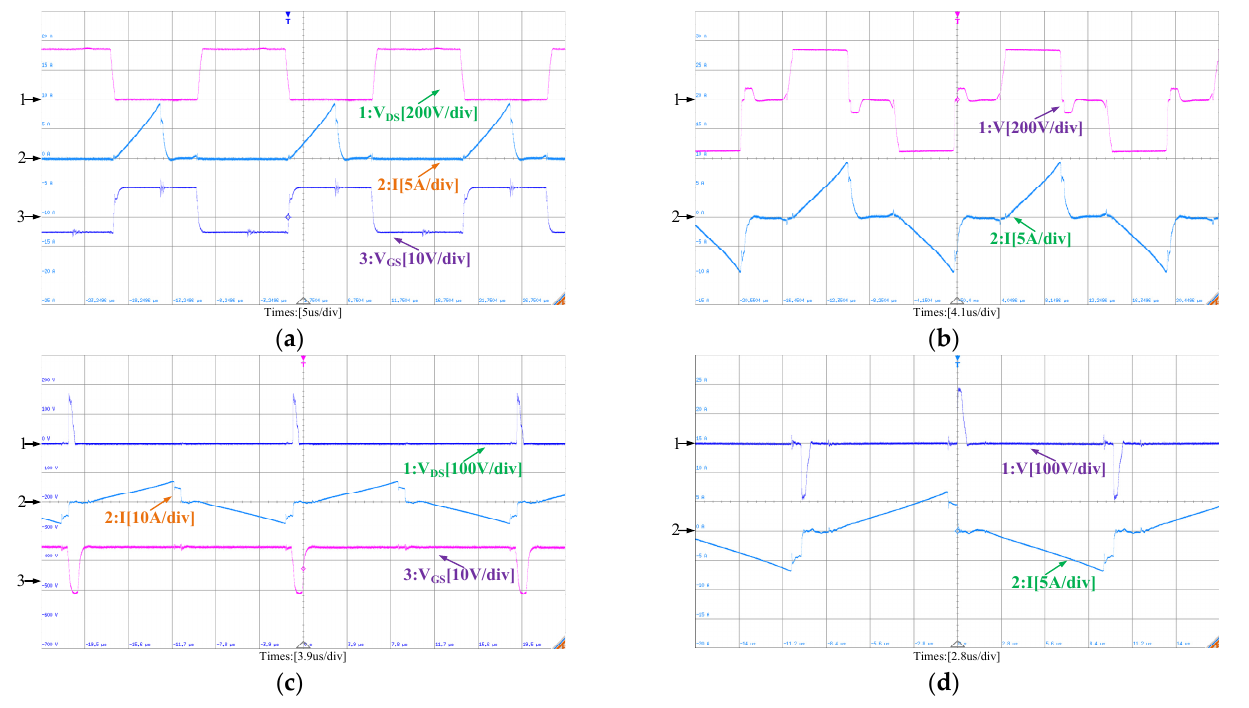
Figure 11. Experimental waveforms: ( a ) three-phase inverter bridge ( 1:𝑉 (cid:3005)(cid:3020) [200 V/div], 2: 𝐼 [5 A/div], 3: 𝑉 (cid:3008)(cid:3020) [10 V/div]); ( b ) primary side of the main transformer ( 1:𝑉 [200 V/div], 2:𝐼 [5 A/div]); ( c ) auxiliary switch ( 1: 𝑉 (cid:3005)(cid:3020) [100 V/div], 2: 𝐼 [10 A/div], 3: 𝑉 (cid:3008)(cid:3020) [10 V/div]); ( d ) auxiliary transformer ( 1: 𝑉 [100 V/div], 2:𝐼 [5 A/div]).